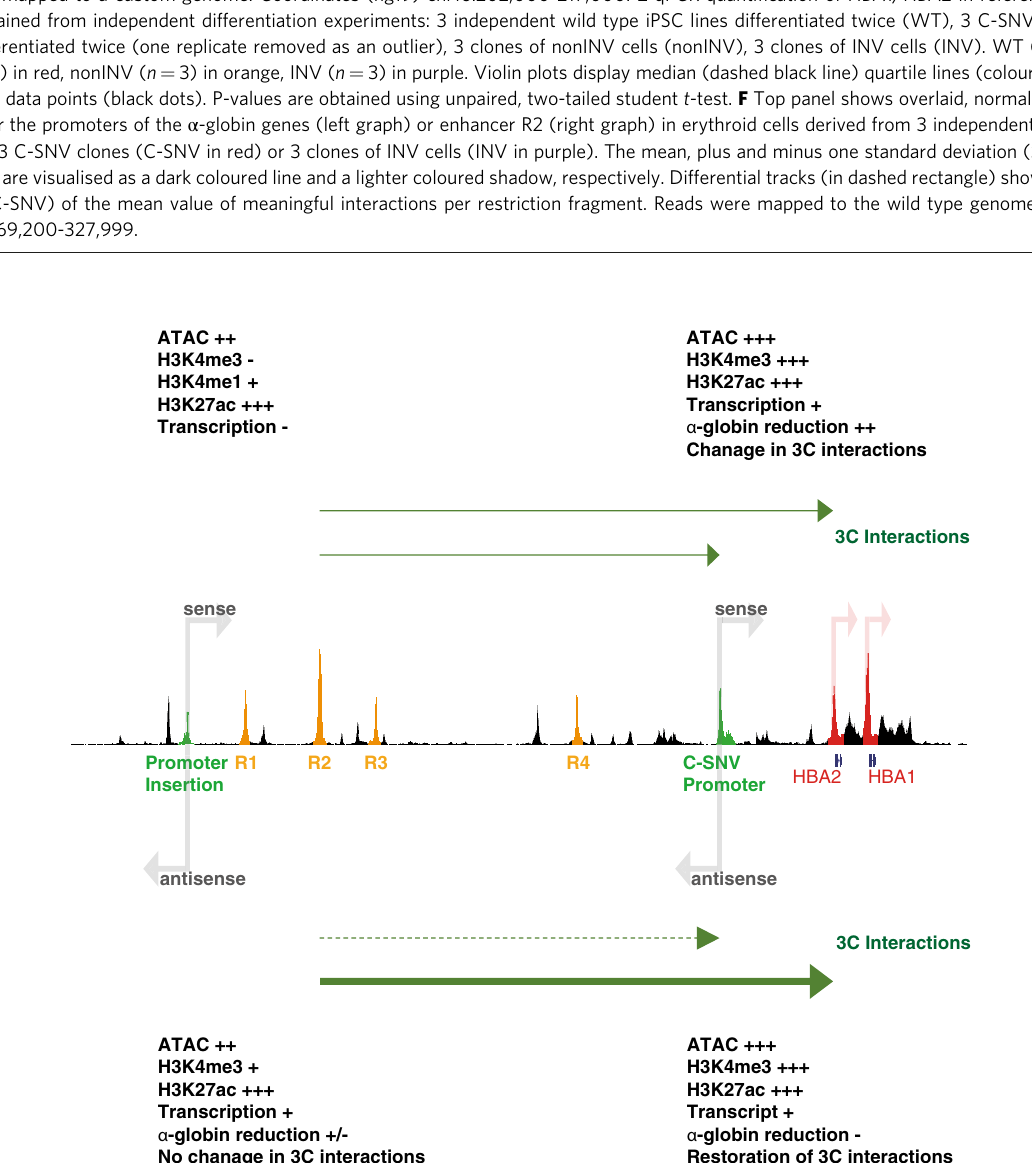
Fig. 6 C-SNV promoter behaviour in different contexts within the α -globin locus. Schematic shows the effect the active C-SNV promoter has on the regulation of the α -globin locus when placed either in its native location (labelled C-SNV promoter in green) or inserted behind the α -globin enhancers (labelled Promoter insertion in green). Elements of importance are highlighted on an arti fi cially merged ATACseq track: enhancers R1-R4 in orange and HBA2/1 genes in red. The effects of the different genomic arrangements are adjacent to the conformation of the element on the schematic.